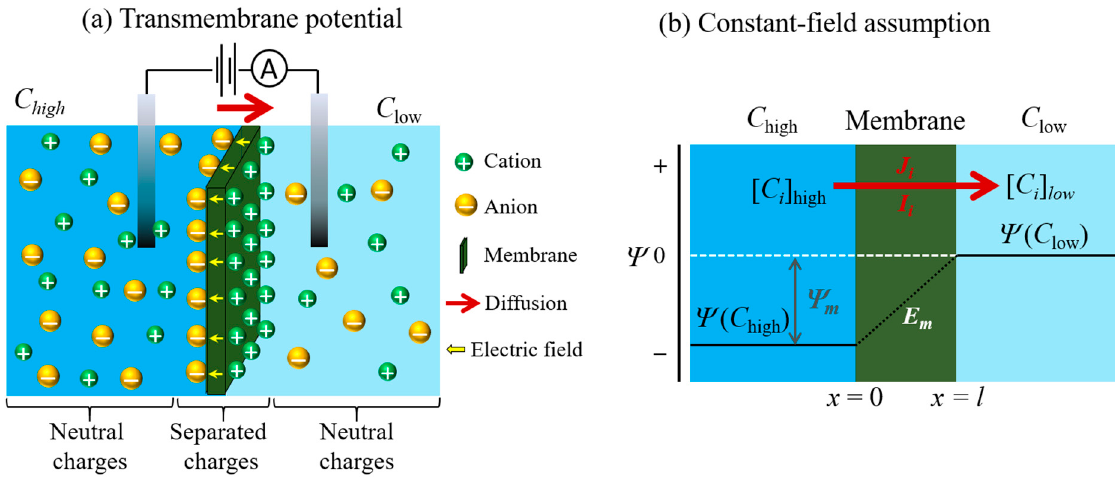
Figure 9. ( a ) Schematic of ion transport through a semipermeable membrane (a cation-exchange membrane in this example) showing the difference in ion concentration between two liquid reservoirs separated by the membrane. The red and yellow arrows represent the diffusion force and migration direction within the membrane, respectively. ( b ) Electrodiffusion model in the membrane illustrating the constant field assumption. According to Goldman’s Assumption, the electrical field is the same at all positions along the membrane thickness ( dE / dx = constant). The field is the electric potential difference between two liquid reservoirs ( E permeate –E feed ) through the membrane thickness ( l ). The flow of ions ( i ) across a semipermeable membrane is related to a molar flux ( J i ) and electric current density ( I i ). The ionic concentration and the electric potential in the membrane are C i and E m respectively. Note the reduced potential ( Ψ ) is Ψ = FE m / RT .